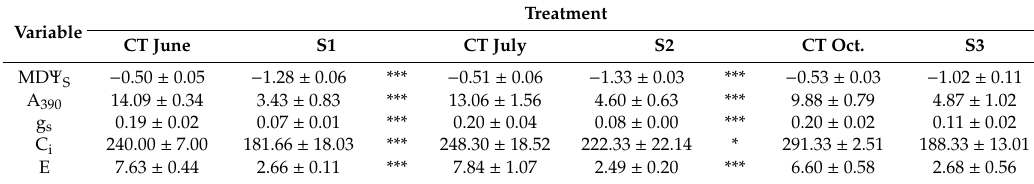
Table 1. Stem water potential (MD Ψ S ) and leaf gas exchange of apricot treated with di ff erent irrigation (CT: control, S1 = drought in June; S2 = drought in July; S3 = drought in October). Data represent the average of at least ten measurements. MD Ψ S : midday stem water potential (MPa); A: net